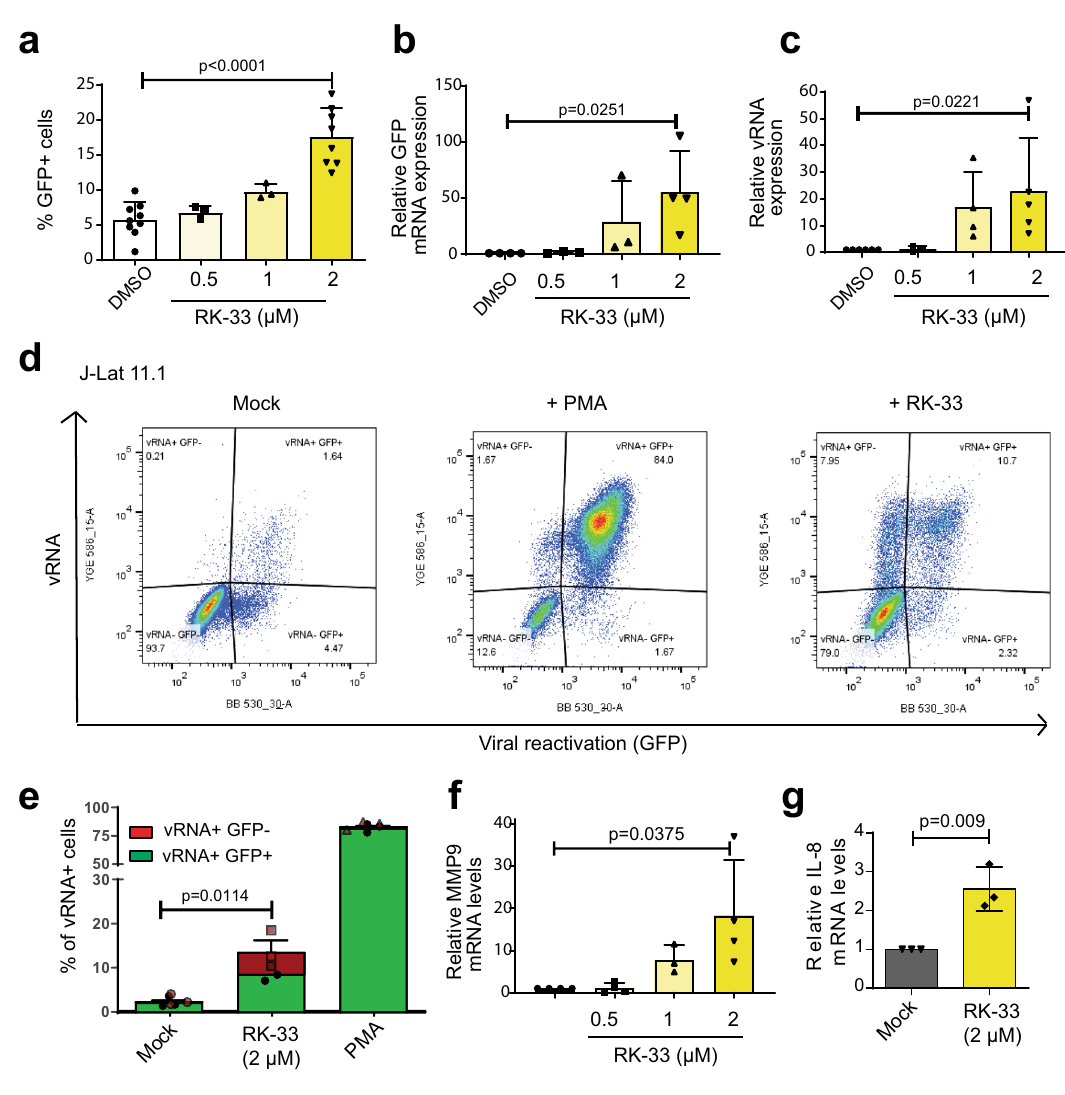
Fig. 1 DDX3 inhibition reverses HIV-1 latency in J-Lat 11.1 cells. a J-Lat 11.1 cells were treated with increasing concentrations of the DDX3 inhibitor RK-33. % of reactivation, monitored by GFP production, was quanti fi ed by Flow cytometry. Error bars represent mean ± SD of three to nine independent experiments with at least 10,000 cells counted per treatment (paired, two-tailed t -test). The relative expression levels of ( b ) GFP mRNA and ( c ) vRNA in the RK-33-treated J-Lat cells were quanti fi ed by RT-qPCR. Error bars represent mean ± SD of three to fi ve independent experiments (unpaired, two-tailed t -test; p value <0.00001). d Representative FISH-Flow dot plots from an independent experiment of J-Lat cells treated with DMSO (Mock), PMA or 2 μ M RK-33. Gating strategy as depicted in Supplementary Fig. 1a. e The % of vRNA-expressing cells (GFP − or GFP + ) as treated in a were quanti fi ed. Error bars represent mean ± SD of three independent experiments with at least 10,000 cells counted per treatment (unpaired, two-tailed t -test). Relative ( f ) MMP9 and ( g ) IL-8 mRNA expression levels from cells treated as in a were quanti fi ed by RT-qPCR. Error bars represent mean ± SD of three to four independent experiments (unpaired, two-tailed t